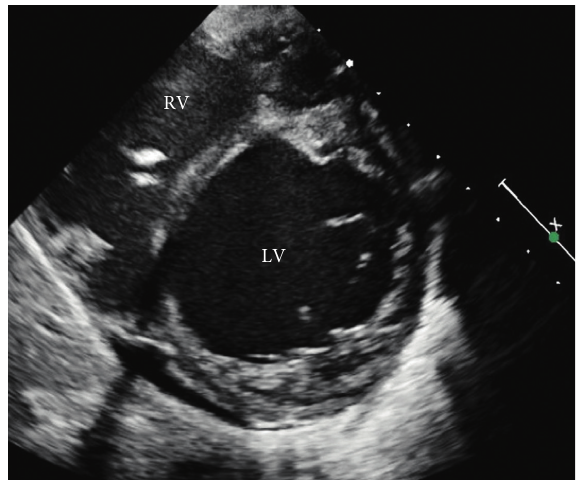
Figure 2: Parasternal short-axis view of the left ventricle revealing hypertrabeculations and deep intertrabecular